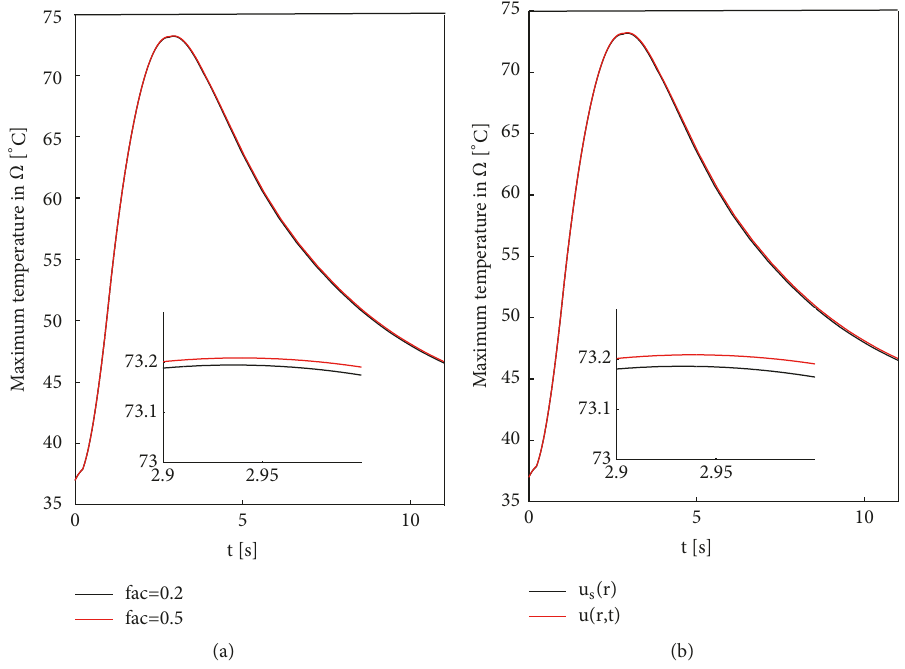
Figure 5: Maximum temperature in space 𝑟, 𝑧 ∈ Ω versus time: (a) different 𝑓𝑎𝑐 ( 𝑓𝑎𝑐 = 0.2 and 𝑓𝑎𝑐 = 0.5 ); (b) different blood flow velocity forms (steady parabolic velocity 𝑢 𝑠 (𝑟) and pulsatile velocity 𝑢(𝑟, 𝑡) ). Here, 𝑝 0 = 1.5×10 5 𝑝𝑎 , 𝑟 0 = 1 𝑚𝑚 , 𝑑 = 1.5 𝑚𝑚 , 𝑢 𝑎 V 𝑒 = 5𝑐𝑚/𝑠 , 𝑓 𝑝 = 1 𝐻𝑧 , 𝑡 = 1𝑠 . ℎ